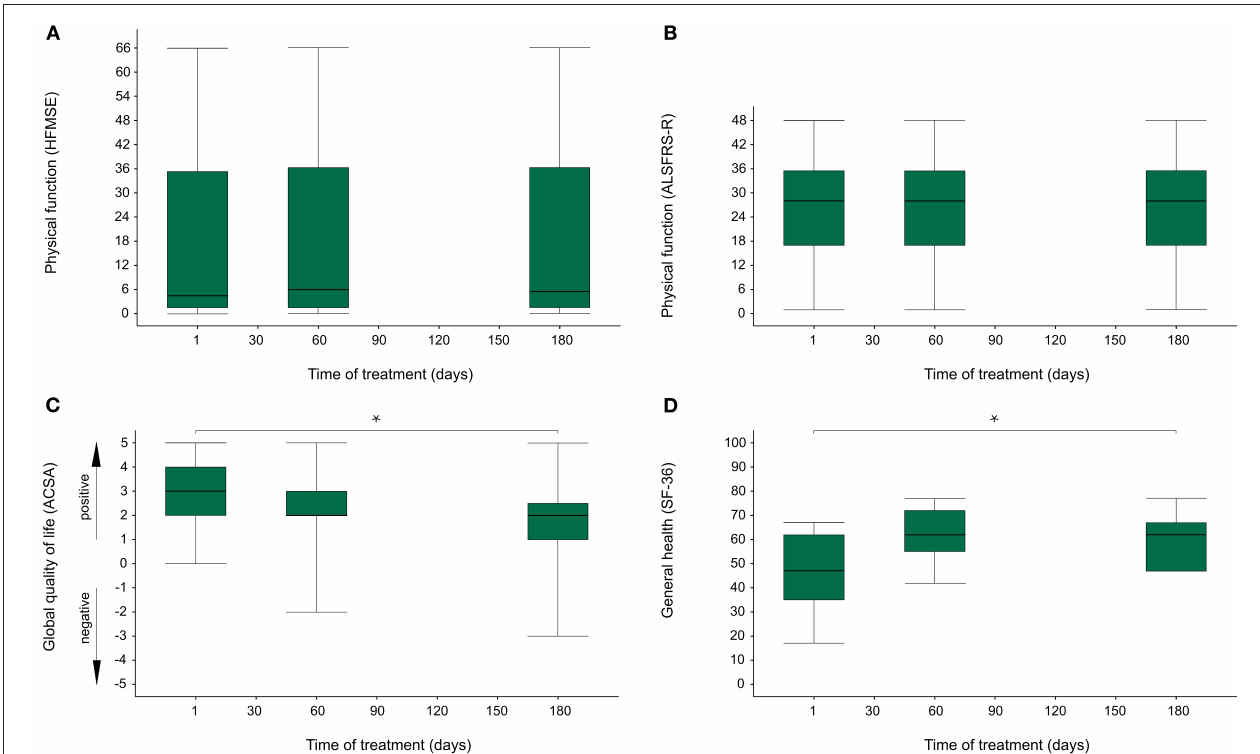
FIGURE 1 | Physical function, global quality of life and rating of general health over the first 6 months of treatment with nusinersen. (A) N = 21; Physical function (HFMSE) in SMA types II and III was evaluated with Hammersmith Functional Motor Scale Expanded (HFMSE), where a value of 0 indicates minimum physical function, and a value of 66 indicates maximum physical function; physical function did not change significantly over the first 6 months of treatment with nusinersen [ χ 2 (2) = 5.042, p = 0.080]. (B) N = 25; Physical function in all subgroups was evaluated with ALS Functional Rating Scale revised form (ALSFRS-R), where a value of 0 indicates minimum physical function, and a value of 48 indicates maximum physical function; physical function did not change significantly over the first 6 months of treatment with nusinersen [ χ 2 (2) = 3.000, p = 0.223]. (C) N = 21; Global quality of life (gQoL) in all subgroups was evaluated with Anamnestic Comparative Self-Assessment (ACSA), where values above zero (max. 5) indicate a positive well-being, while values below zero (min. − 5) indicate a negative well-being; gQoL decreased significantly over the first 6 months of treatment with nusinersen [ χ 2 (2) = 6.30, p = 0.043]. (D) N = 11; Rating of general health in adult SMA patients was assessed with Short Form 36 Health Survey (SF-36), where a value of 0 indicates the worst possible rating of general health, while a value of 100 indicates the best possible rating of general health; the rating of general health increased significantly over the first 6 months of treatment with nusinersen [ χ 2 (2) = 7.80, p = 0.021]. *indicates a significant change of values over time in Friedman’s